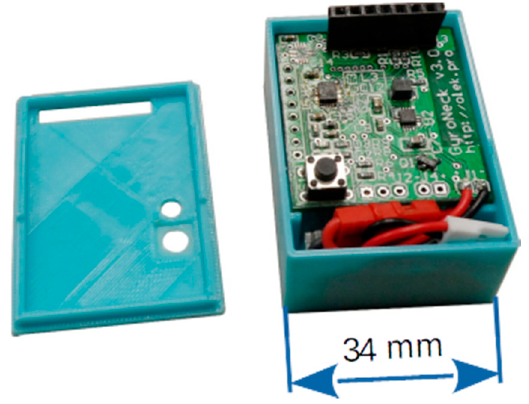
Figure 1. Measurement device.